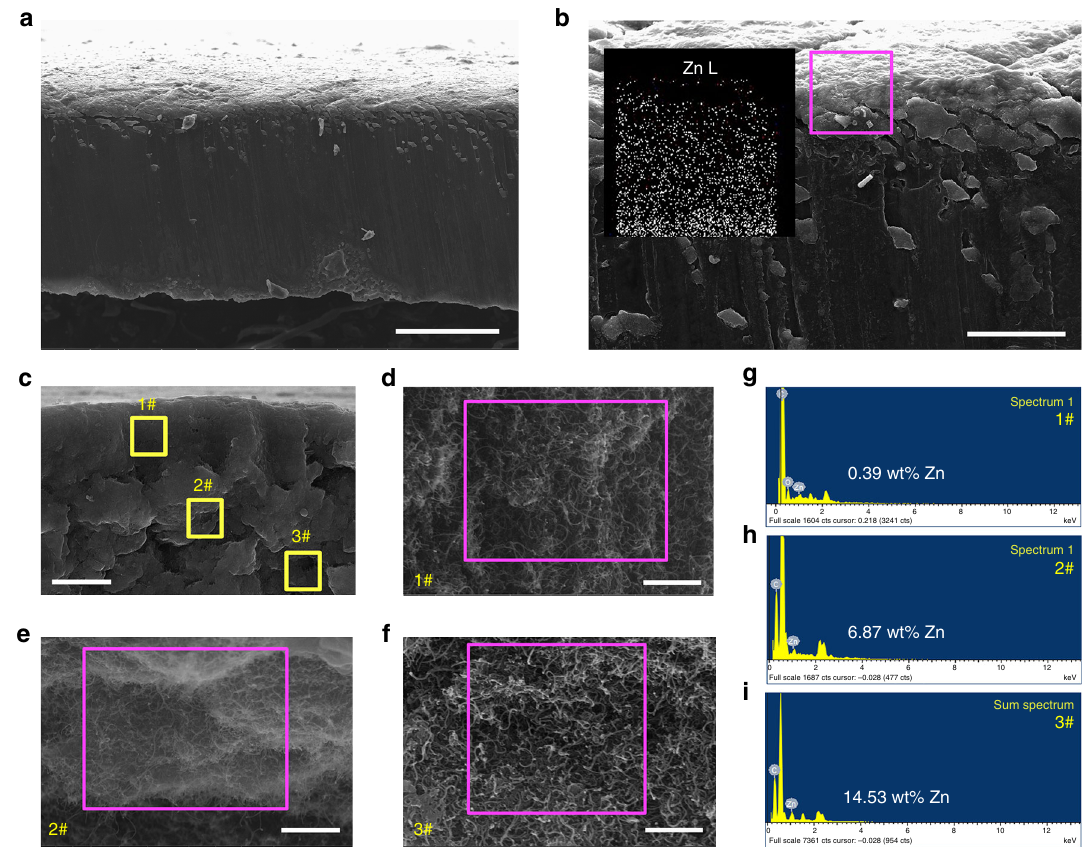
Fig. 5 Characterization of the gradient ZnO-coated CNT (GZCNT). a – f Cross-sectional SEM images of a , b pristine GZCNT-coated Li foil and c – f the GZCNT interfacial layer. Inset in b is the corresponding Zn (Zn – L) elemental EDX mapping image of GZCNT interfacial layer highlighted by pink. Morphology of #1 upper ( d ), #2 middle ( e ), and #3 under ( f ) parts of layer highlighted by yellow in c . g – i Corresponding elemental EDX spectrum of GZCNT interfacial layer, indicating that the Zn content of the d upper, e middle, and f lower parts of the layer are g 0.39, h 6.87, and i 14.53 wt%, respectively. Scale bar, 100 μ m for a , 20 μ m for b , 10 μ m for c, and 1 μ m for d –